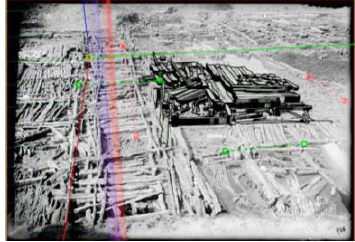
Figure 4: Parallel lines, which determine the vanishing points in the central projection; mutually connected vanishing points create the